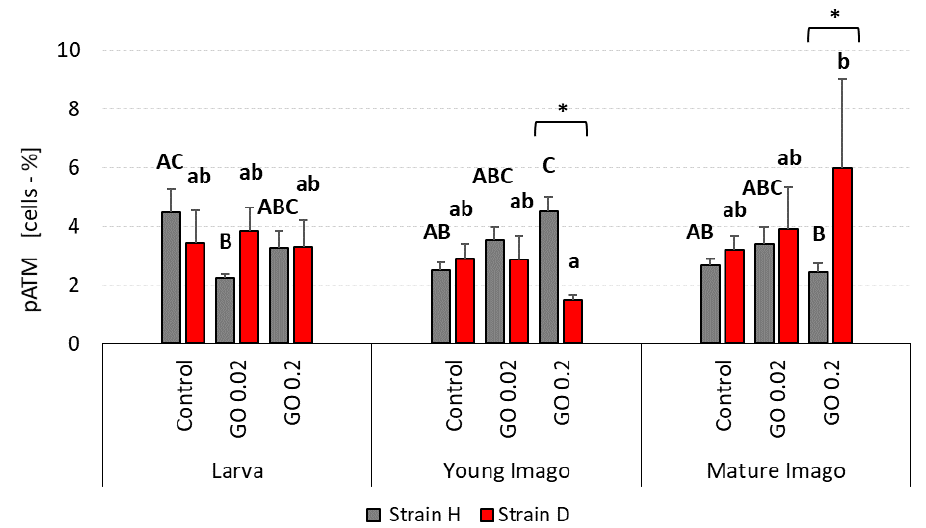
Figure 5. pATM (activated ATM kinase) percentage in the gut cells of the wild (H) and long-living (D) strains of A. domesticus that had been chronically intoxicated with graphene oxide (GO). Measurements were conducted at larva (n = 5), young imago (n = 5) and mature imago stage (n = 3). Abbreviations: see Figure 1. Capital letters refer to strain H, while lowercase letters refer to strain D; asterisks indicate differences between the strains in each experimental group separately.